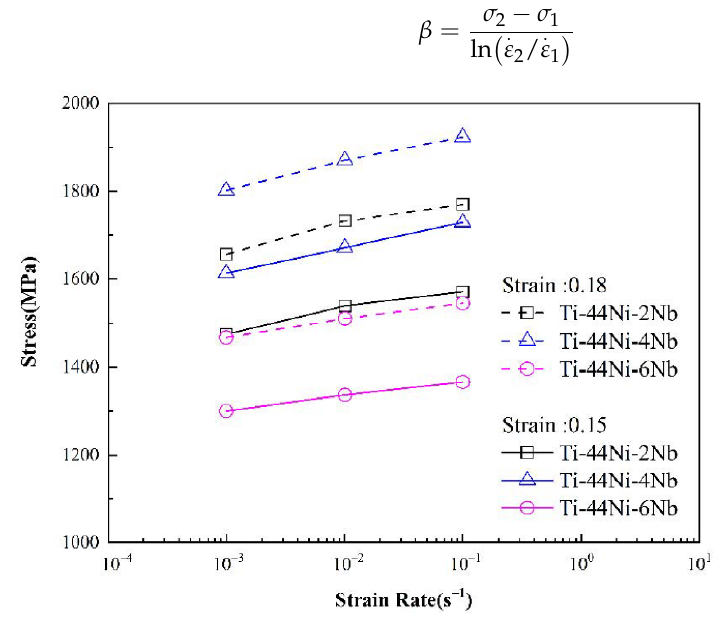
Figure 6. Variation of plastic flow stress with strain rate under static deformation conditions.